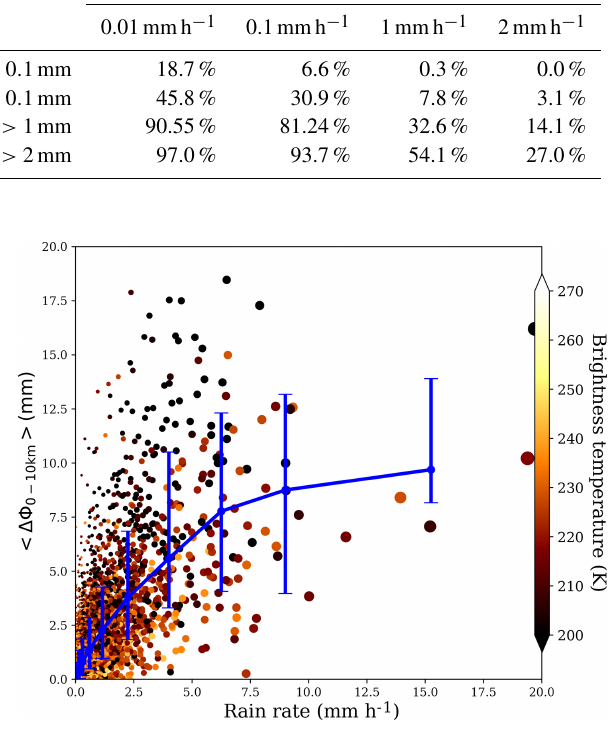
Table 1. Summary of Fig. 12 for some representative thresholds. Rain threshold